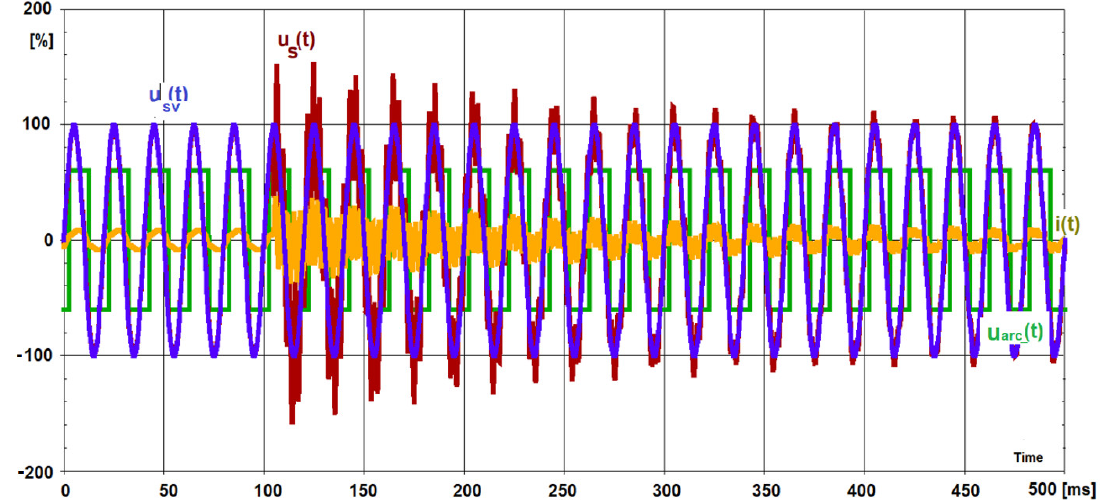
Figure 26. Oscillograms of the supply (source) voltage U SV ( t ), the arc furnace supply voltage U S ( t ), the arc voltage U arc ( t ), and the arc furnace current i ( t )—switching on the capacitor bank, with high short-circuit power of the network [31].